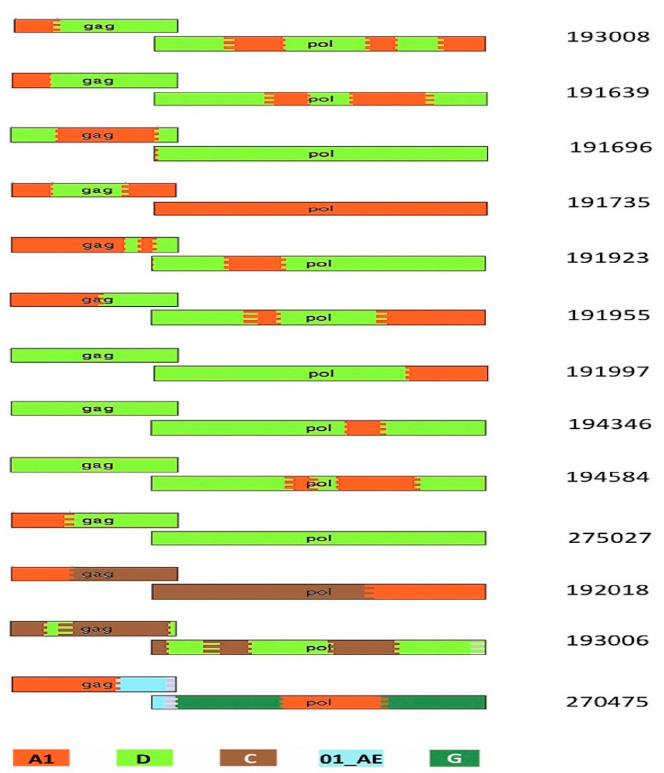
Figure 1. HIV-1 breakpoint map showing the recombination patterns across the 13 recombinants. This was generated using the jpHMM website and recombinant HIV-1 drawing tool from the LANL website as described in Materials and Methods. The key to colors in the figure: red as A1, light green as D, brown as C, dark green as G and light blue as